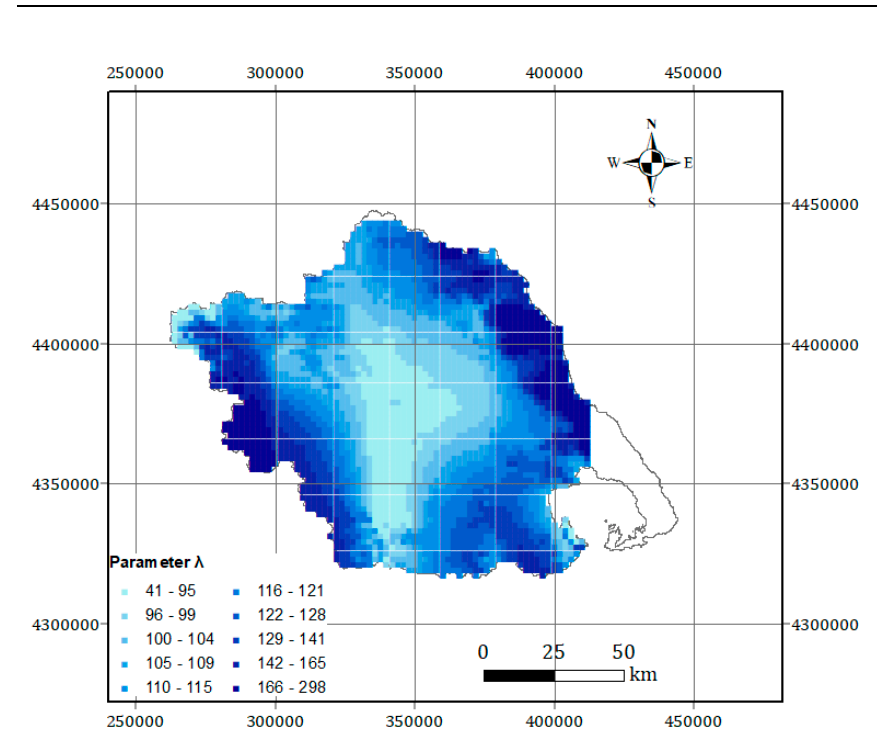
Figure 6. Spatial estimation of the scale parameter (cid:2019) (mm/h).